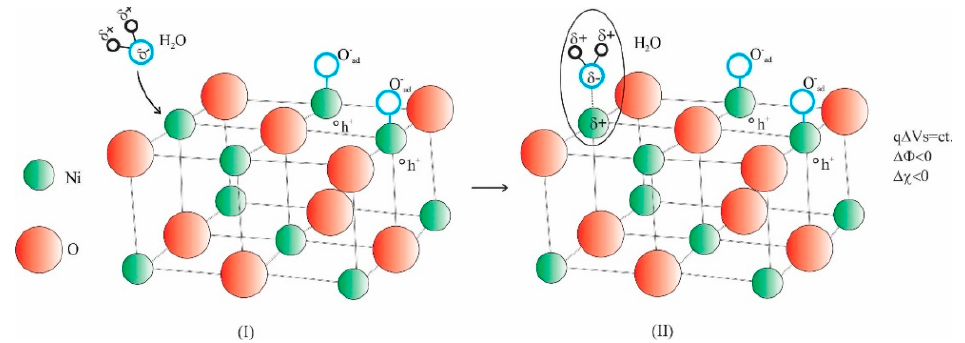
Figure 12. Cartoon revealing the interaction between atmospheric moisture and NiO surface. Due to molecular water physisorption, the band-bending remains constant while a strong decrease in the electronic affinity and work function was recorded.